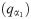
Multifarious eruptions of urticaria and simulation results.(A-F) Patterns of representative urticaria eruptions developed in patients (lower or right panels), and patterns simulated (upper or left panels) by parameters notated by (q0), (qα1), (qα2), (qα0), (qμ), (qγ), (qF), (qU) in (Fig 2D–2G) were assigned to similar eruptions developed in real patients with urticaria. The right-hand side figure in C was generated with a stronger initial stimulus than that in the left-hand side figure. The time of simulation result is notated in each figure. (G) Wheal patterns for the increase in the strength of the stimulus (Pr). The density of wheals is notably increased. (H) Wheal patterns are shown with respect to two different weight functions of ψ(x) with the fixed Pr. α2 = 5.0,u* = 0.181, and the other parameters chosen were listed in Table 1 (Set I) for (G) and (H).